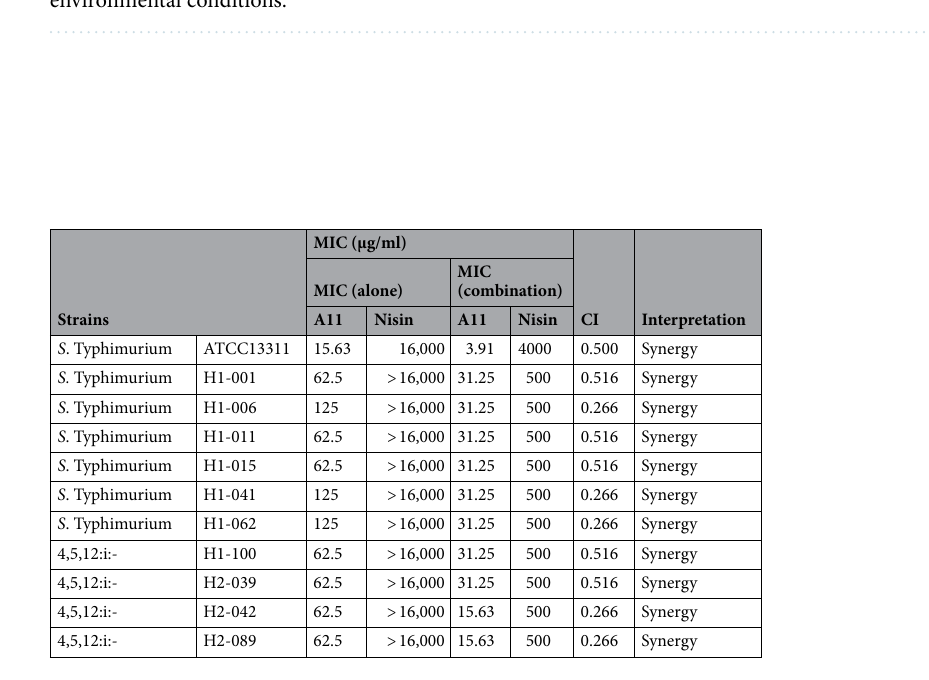
Table 5. In vitro interaction between A11 peptide and nisin against 10 drug-resistant Salmonella enterica strains. At MIC value of > 16,000 µg/ml, a value of 32,000 µg/ml was used to calculate the combination index (CI).